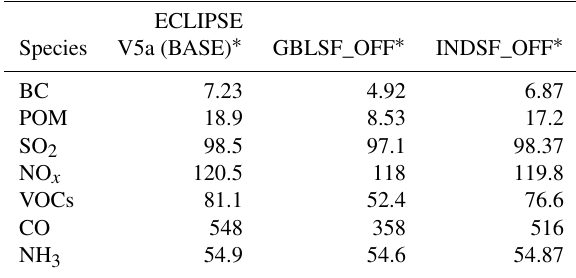
Table 1. Annual budget for various species for the BASE, GBLSF_OFF and INDSF_OFF simulations for the year